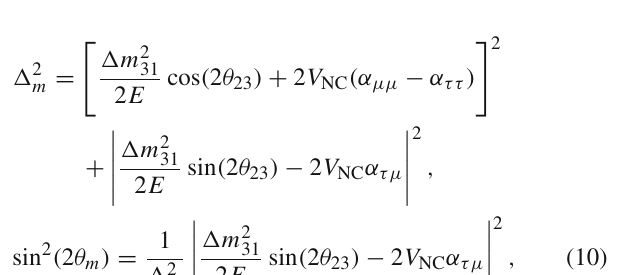
Table 1 The best-fit values and the 3 σ ranges for the mixing and mass parameters taken from Ref. [57]. There are two minima for θ 13 , θ 23 and δ . The first one corresponds to the normal mass ordering whereas the second one corresponds to the inverted mass ordering. The 3 σ ranges are given for either